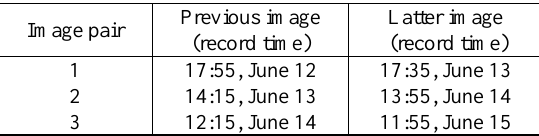
Table 3 Three FY-3/MERSI image pairs for pack ice Motion